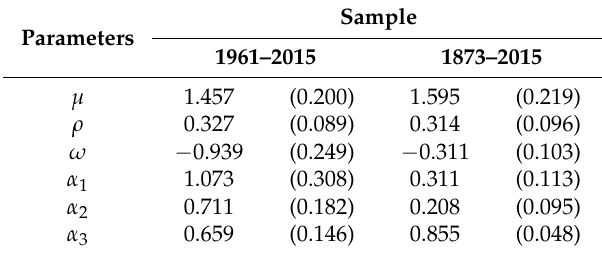
Table 6. Estimated parameters and associated standard errors in the EGARCH